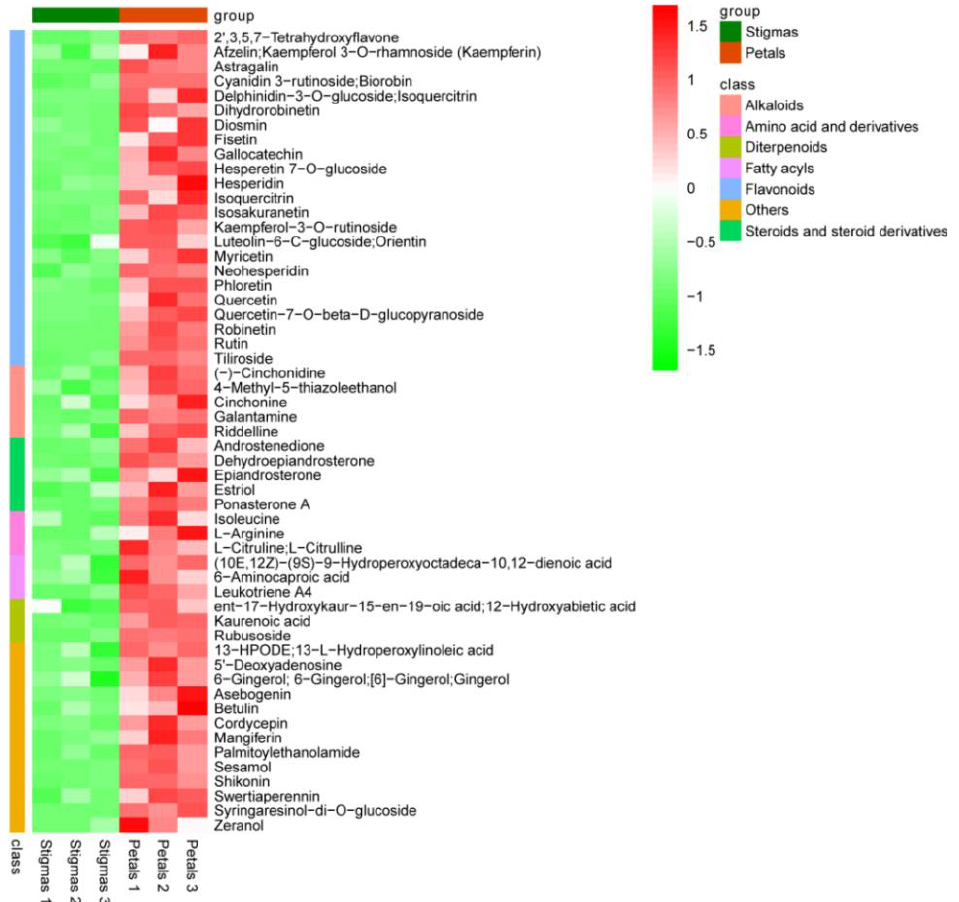
Figure 5. Heat map of the top 55 up-regulated metabolites. The abscissa in the figure represents different experimental samples, and the ordinate represents the differential metabolites compared in the group. Red or green in heatmap indicates high or low expression, respectively, according to the color bar in logarithmic scale shown above the heatmap. The same setup applies to the following Figure 6.